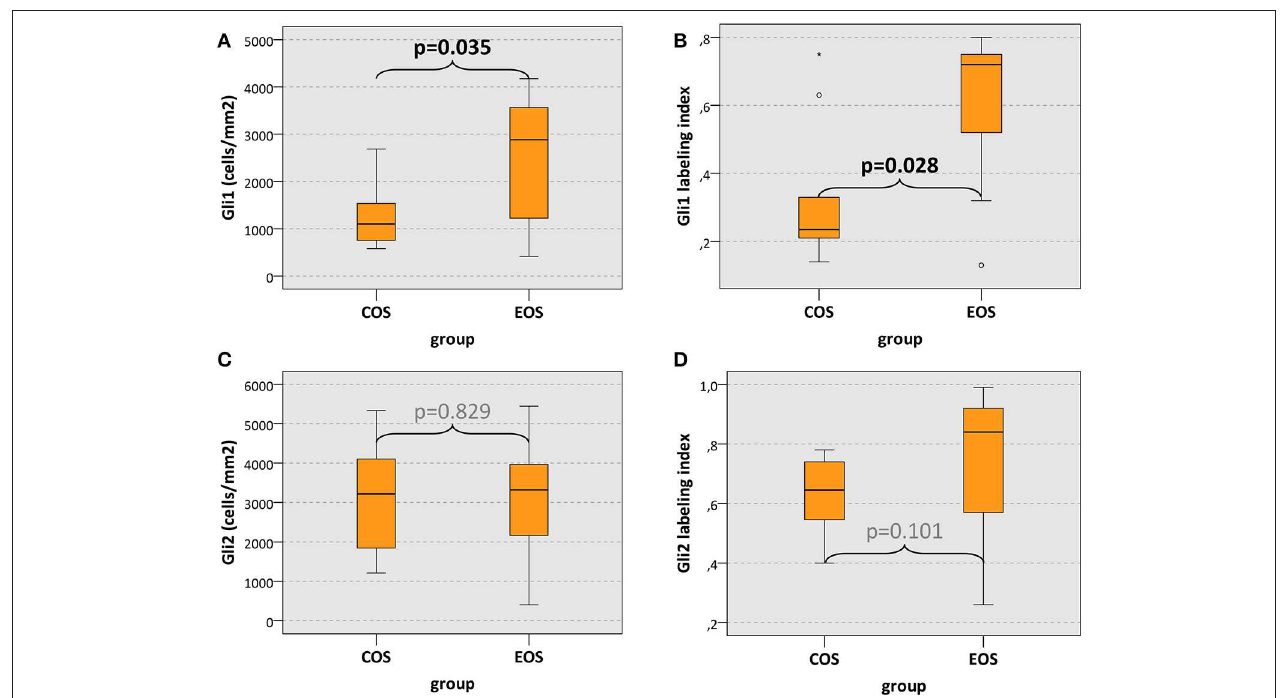
FIGURE 4 | Gli1 and Gli2 expression. (A,C) The box plots show Gli1 and Gli2 expression displayed as cell density (positive cells/mm 2 ) and (B,D) labeling index (percentage of expressing cells). Values for craniofacial osteosarcomas (COS) and extracranial osteosarcomas (EOS) are given. p values are generated by the Mann–Whitney U test. Significant p values are printed in “bold”